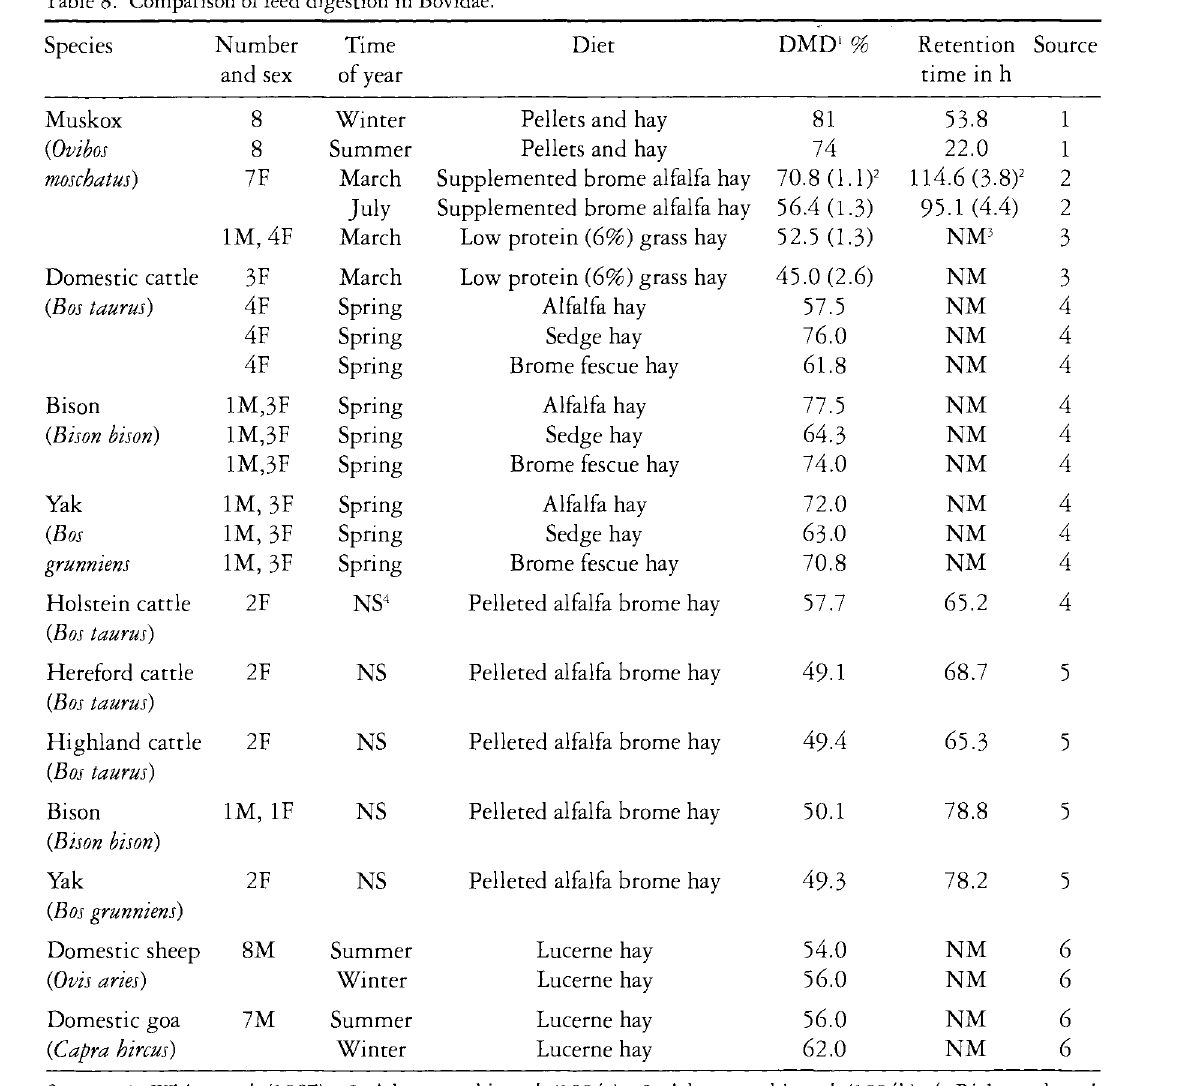
Table 8. Compari: son of feed d: igestion in